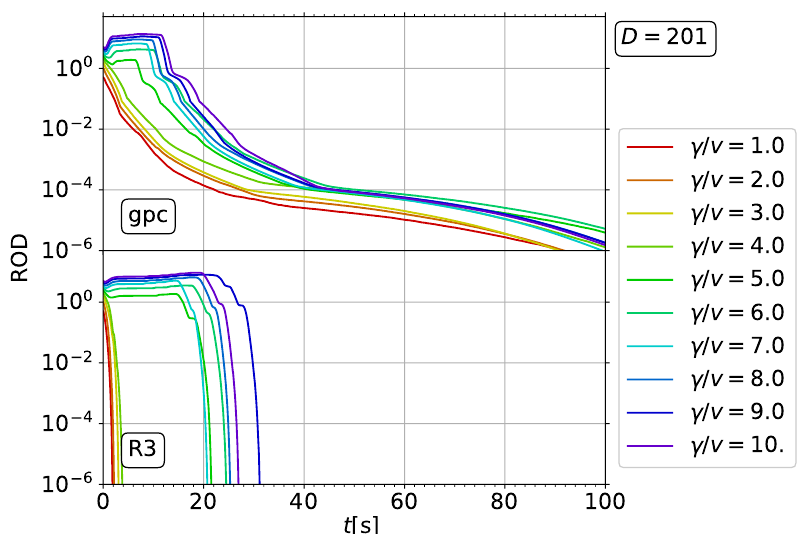
Figure 7: ROD flow of the ordered dissipative scattering model, see (68), calculated with the gpc-generator and R3-generator and D = 201.